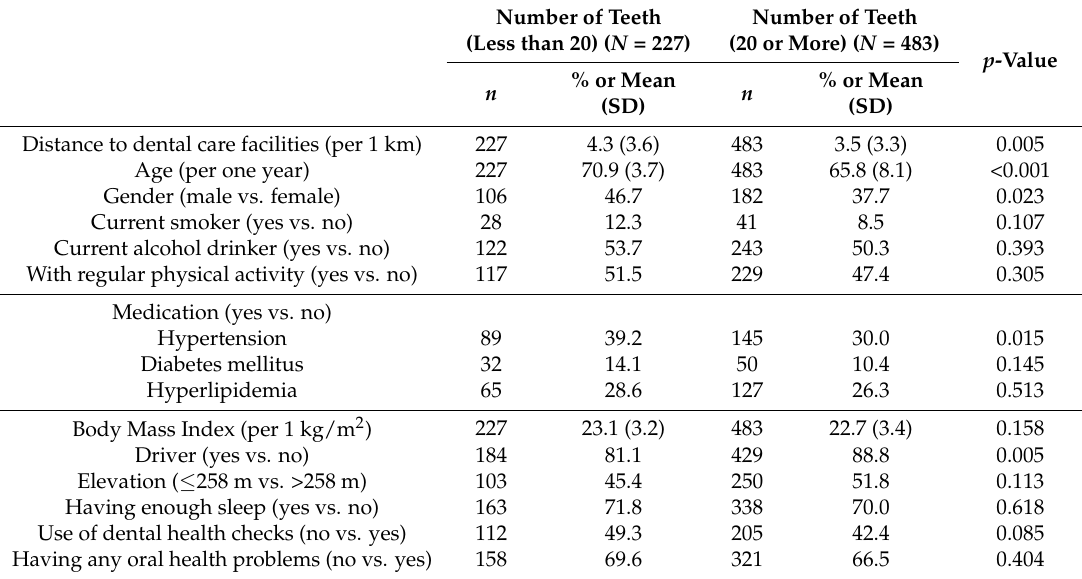
Table 1. Characteristics of study